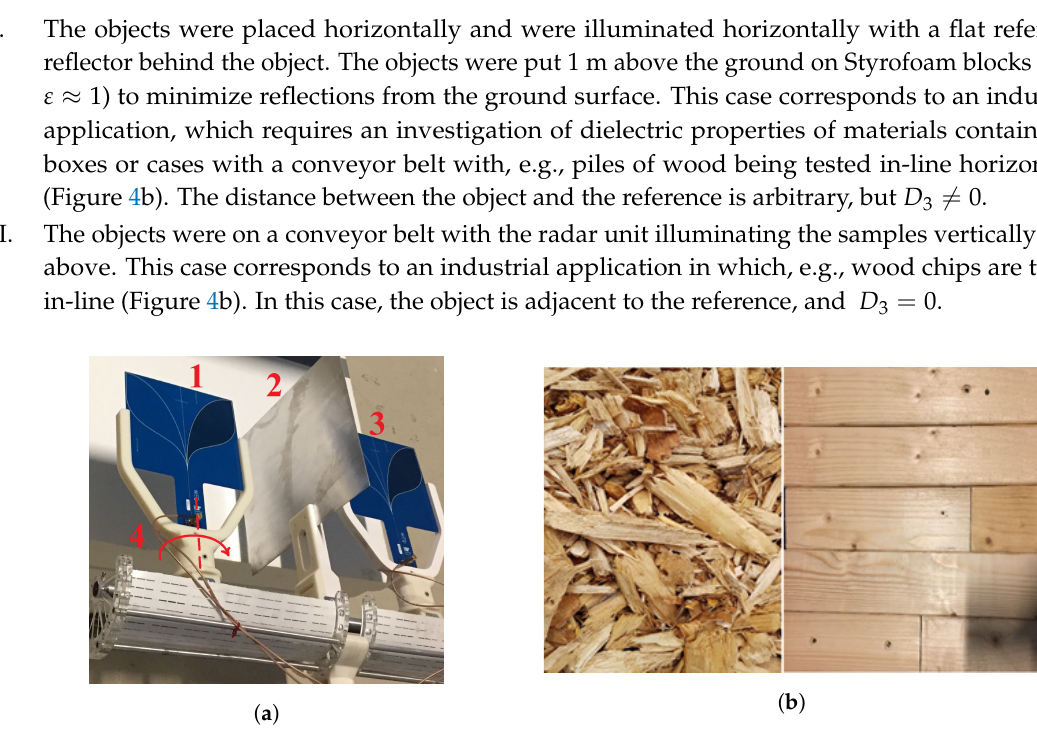
Figure 4. ( a ) Radar unit: (1) Tx Vivaldi antenna, (2) shielding plate, (3) Rx Vivaldi antenna, and (4) rotatory axis. ( b ) Samples: Wood chips (WCs) (left) and solid wood (SW)